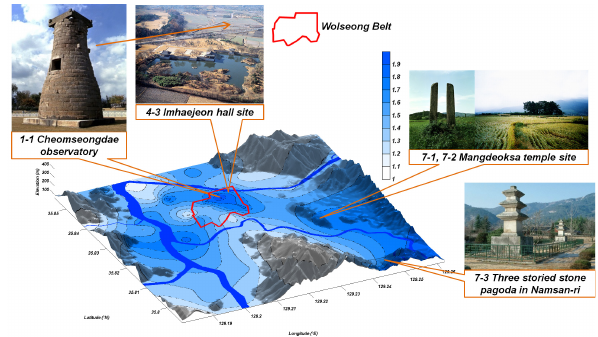
Fig. 7. The procedure of seismic microzonation: (a) three- dimensional digital elevation map by the triangulated irregular net- work; (b) kriging interpolation of geotechnical value; (c) standard geographical information map; (d) combination of digital maps.